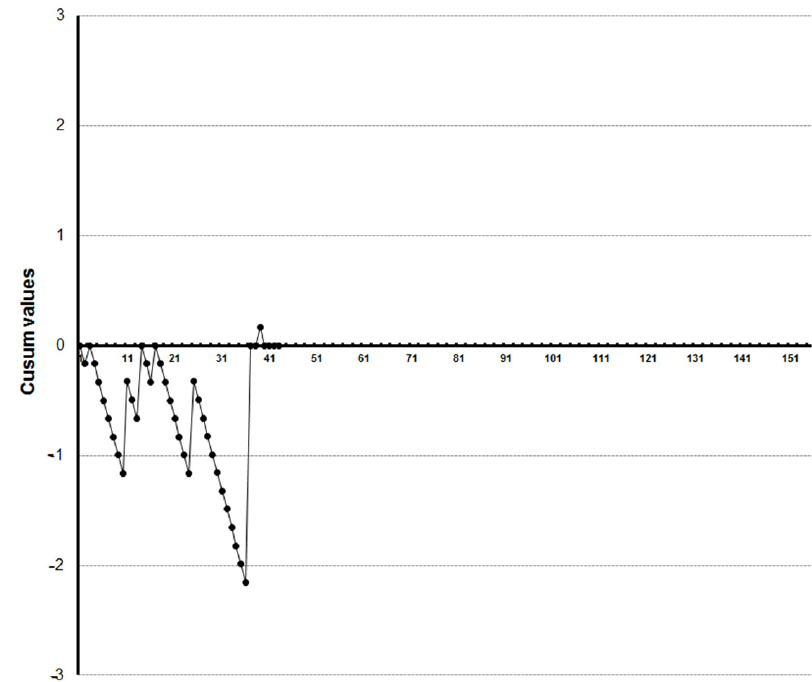
Figure 6. LC-CUSUM curve for trainee two.